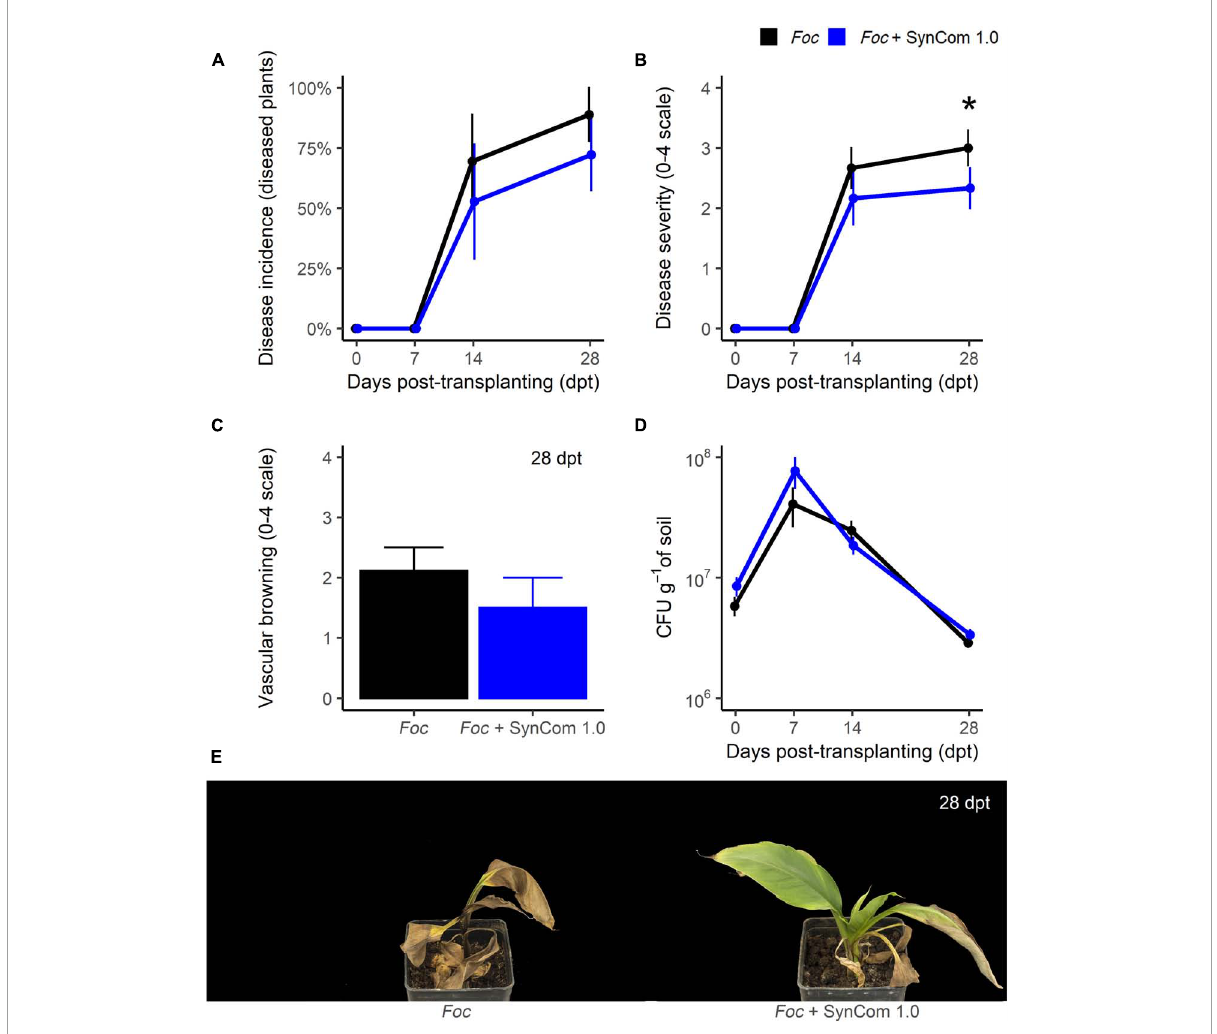
FIGURE3 Biocontrol trial A: SynCom 1.0. Banana plants ‘Gran Enana’ were grown in steam-sterilized soil inoculated with 10 7 CFU g − 1 soil of Fusarium oxysporum f. sp. cubense ( Foc ) tropical race 4, alone or in combination with the synthetic microbial community SynCom 1.0. Fusarium wilt incidence (A) , symptom severity (B) , vascular browning (C) , and Fusarium spp. soil population (D) were measured to assess the biocontrol effectiveness of SynCom 1.0. Symptoms occurring on treated and control plants are shown in (E) . Bars indicate standard error ( n = 15). The asterisk indicates a significant difference between treated and control plants according to Dunn’s test ( P <